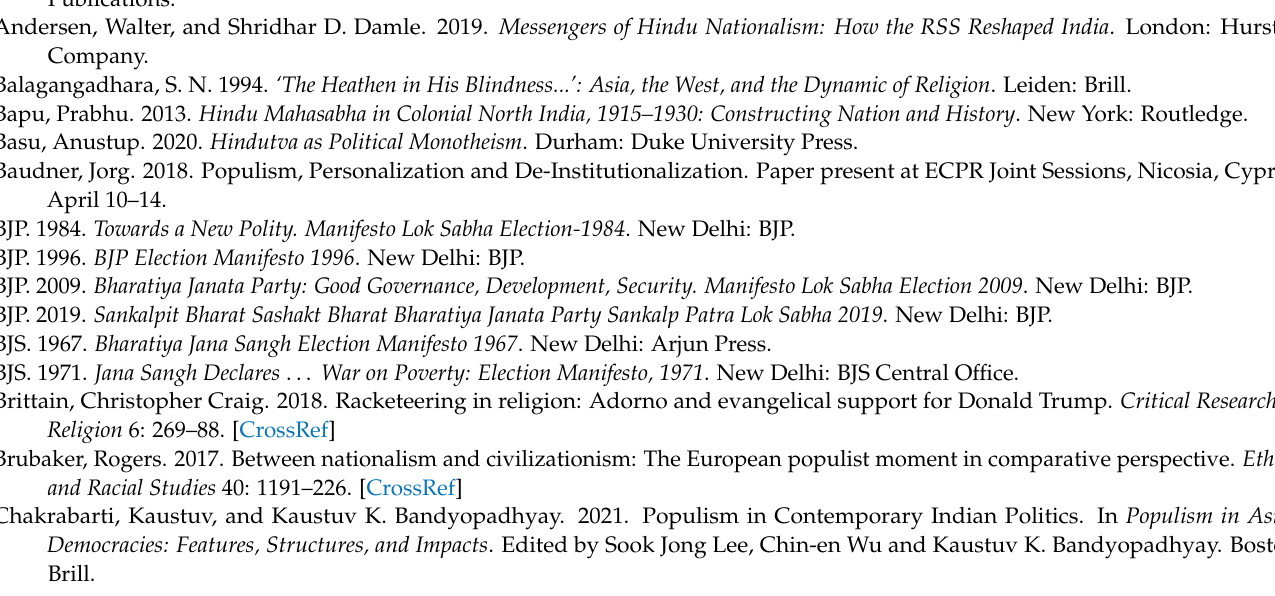
The term rightwing is used here as a convinience and with the acknowledgement that it is very difficult to divide politics into rightwing and leftwing. There are innumerable ways by which the division between leftwing and rightwing politics have been defined and numerous differences within what is called leftwing or rightwing. Therefore, instead of trying to define leftwing or rightwing politics, I will try to explain what leftwing–rightwing dichotomy means in this article. I will follow here professor’s lead and define leftwing politics as the primacy of a thick, expansive socio-political ideal of equality while rightwing, while adhering to its version of equality, does not accept the primacy or thickness of the equality ideal (Lukes 2003, pp. 609–16). In the Indian context, for this article, rightwing politics will, hence, include politics of those who give primacy to a particular tradition, specific religion or other hierarchical